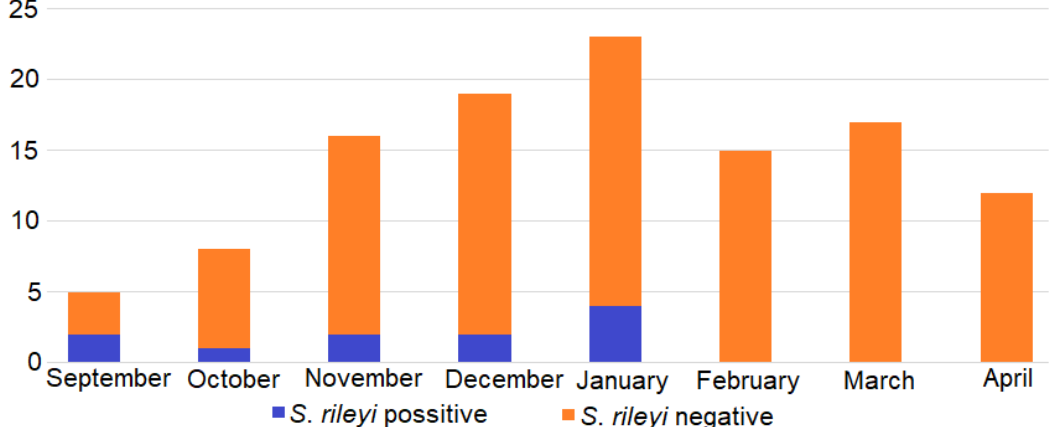
Figure 2. The molecular identification of S . rileyi in the mucosal scrapings of the mustelids collected during different months in Lithuania.